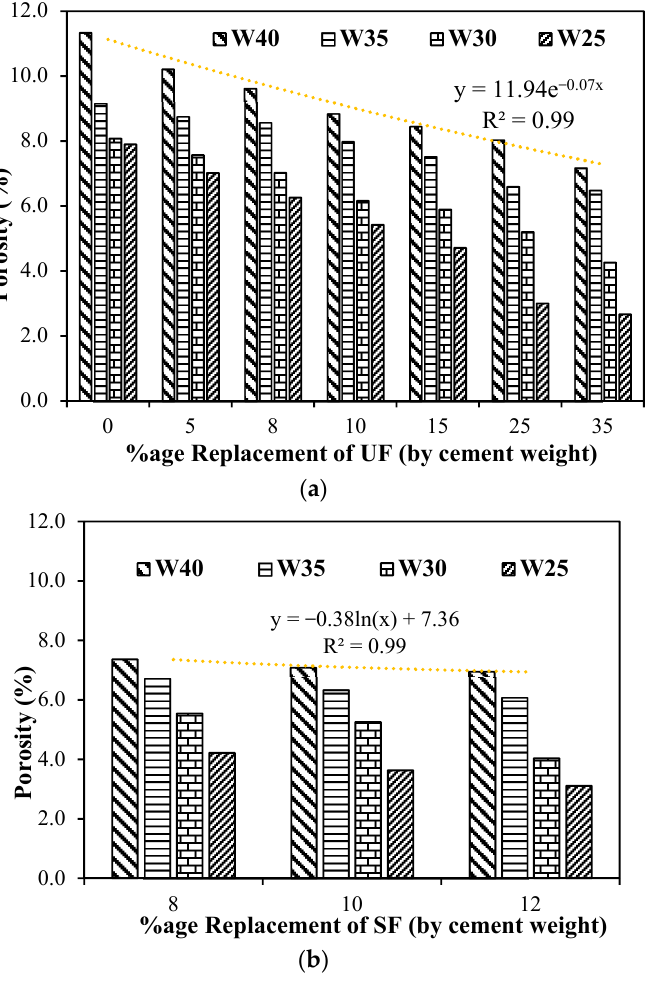
Figure 9. Porosity (%) for different dosages of UF and SF with different w/c ratios: ( a ) porosity (%) for different dosages of ultrafines with different w/c ratios; ( b ) porosity (%) for different dosages of SF with different w/c ratios.